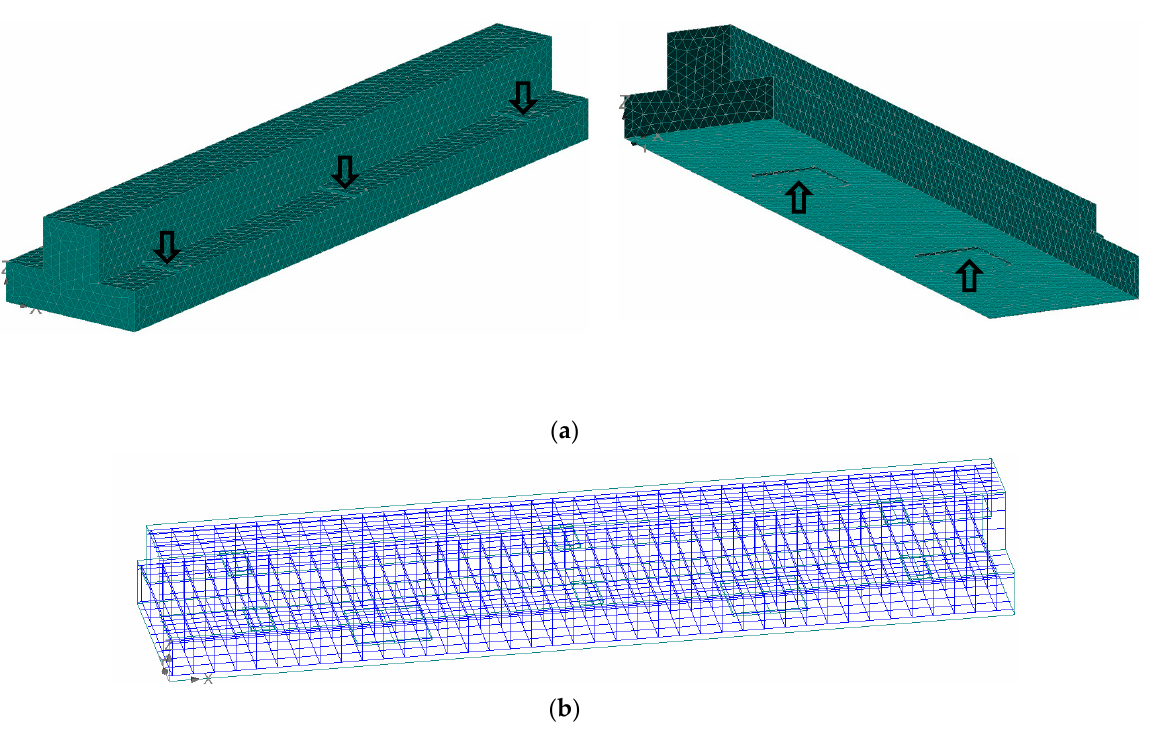
Figure 6. 3D models of inverted T-beam: ( a ) Mesh configuration; ( b ) Geometry and reinforcements.